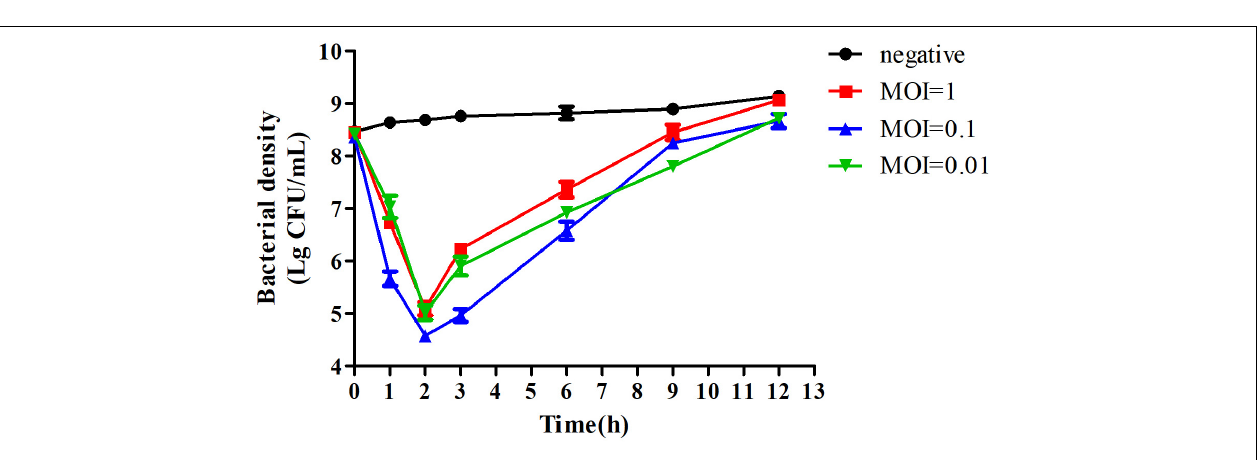
FIGURE 5 | Bactericidal activity of PZL-Ah152 at different multiplicities of infection in vitro . The A. hydrophila -152 strain was lysed by phage PZL-Ah152 in LB medium at 37 ◦ C. CFU counts of the uninfected control culture and the parallel cultures that were infected with the phage at different MOI were measured over time. No phage was added in the negative control. The values represent the means and SD ( n =